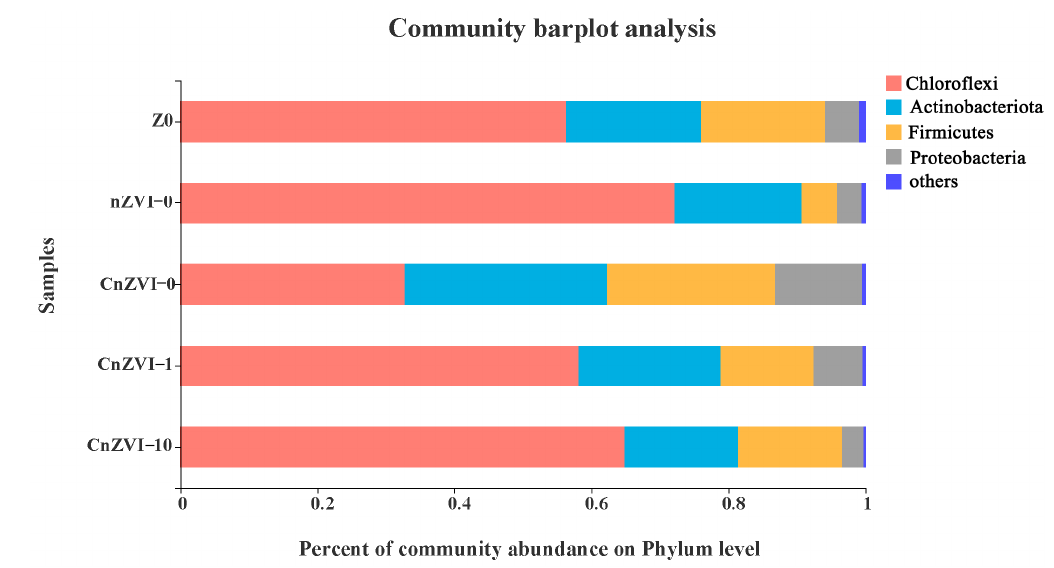
Figure 7. Relative abundance of bacterial 16S rRNA gene at the phylum level.